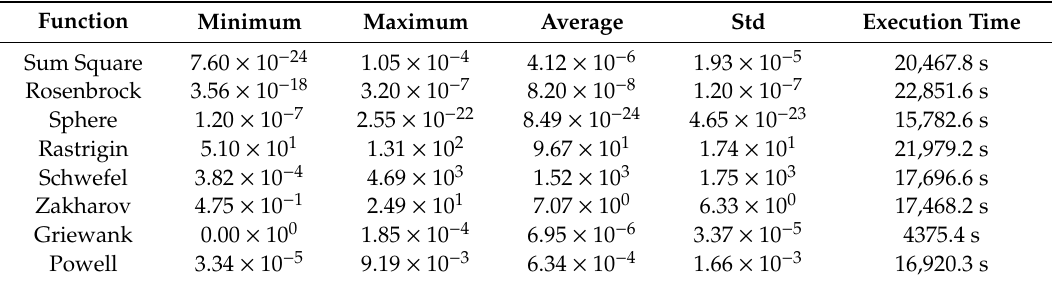
Table 12. Results of the OFDE method applied to benchmark mathematical functions. Function